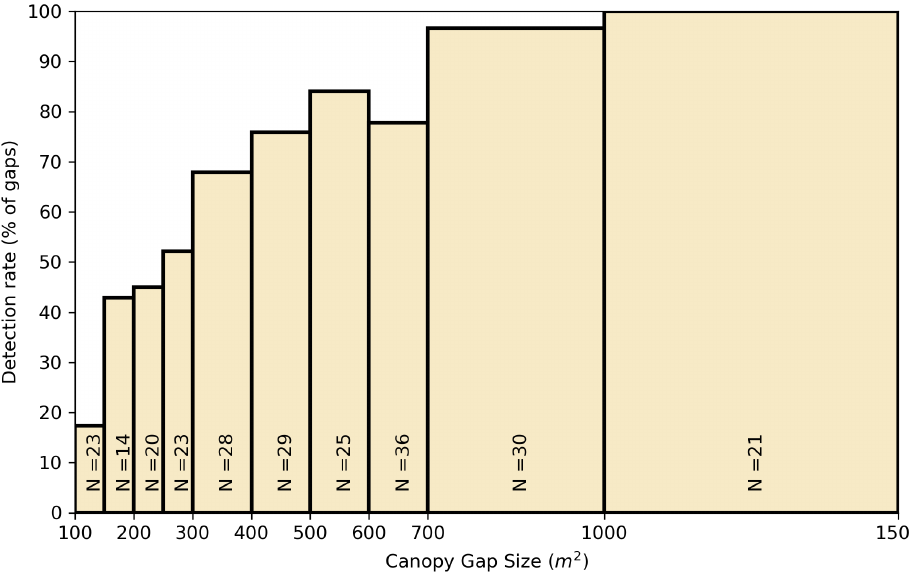
Figure 5. Percentage of canopy gaps detected by Sentinel-1 shadow algorithm using 25 post-event images and no multilooking. Canopy gaps are classed by size, and the number of gaps in each class is indicated by